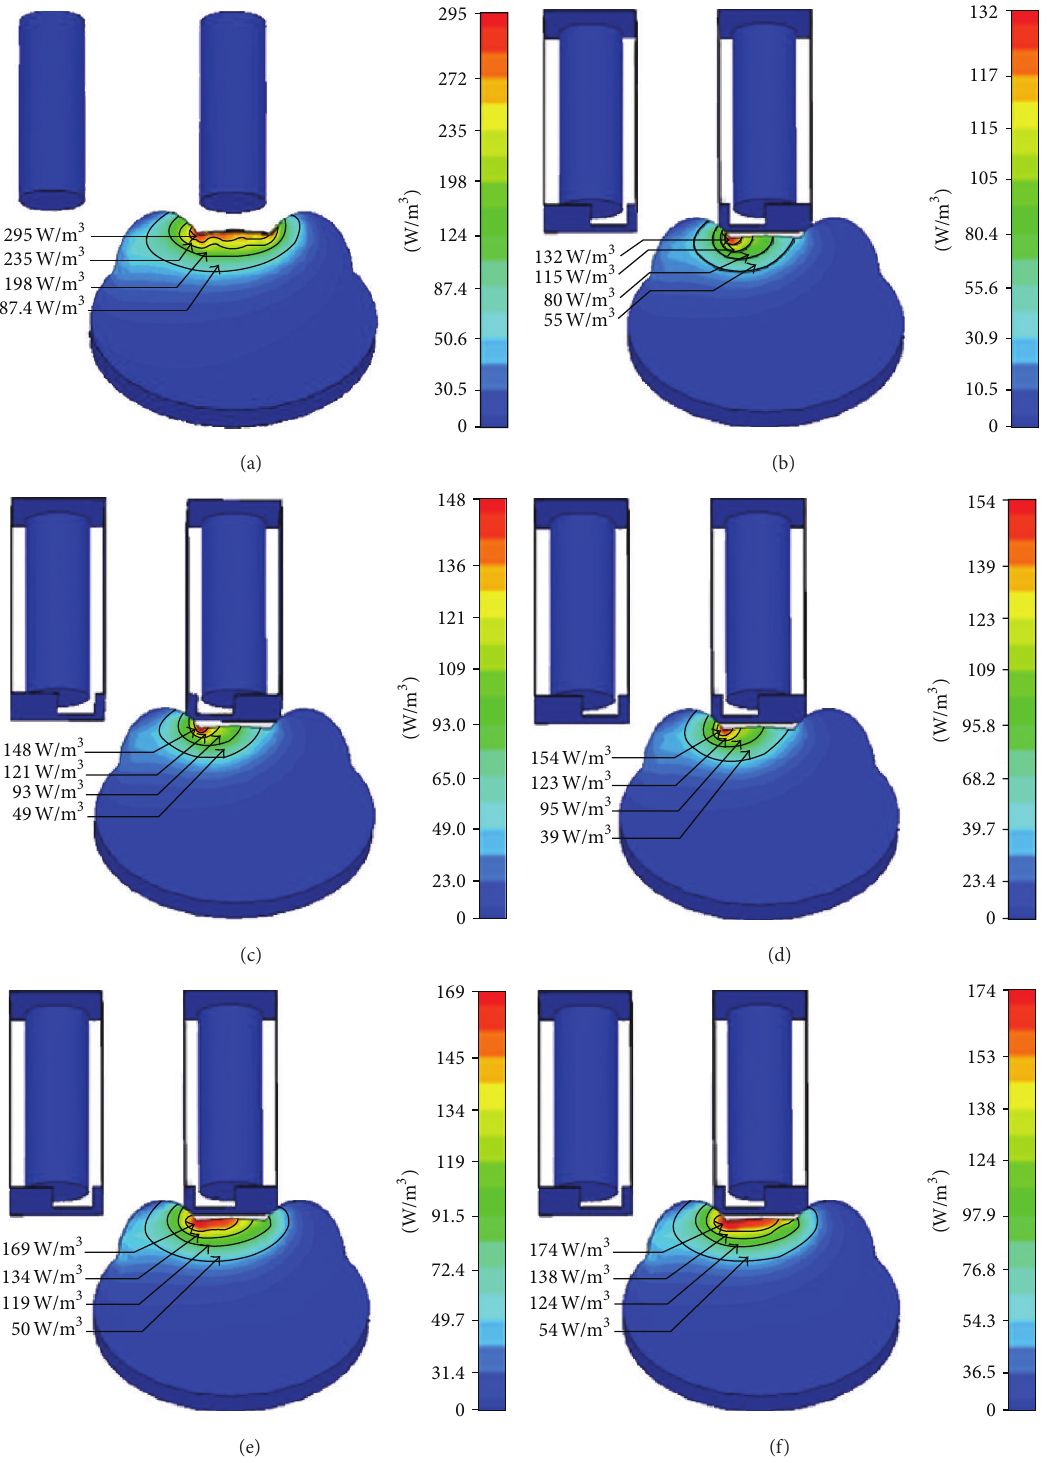
Figure 5: Electric loss density of the heating model for (a) ferrite core without shielding, (b) rectangular shielding with 5cm aperture, (c) rectangular shielding with 7cm aperture, (d) rectangular shielding with 8 cm aperture, (e) rectangular shielding with 9 cm aperture, and (f) rectangular shielding with 10cm